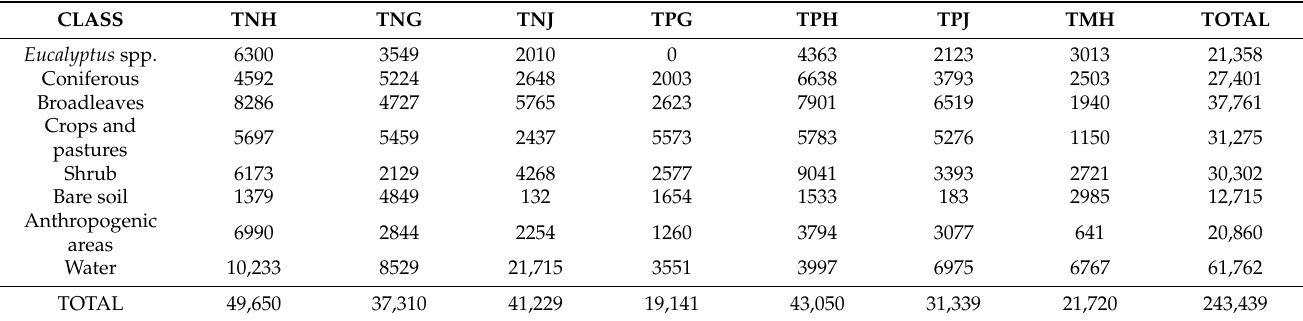
Table 4. Number of 20 × 20 m 2 training pixels by tile and class used to perform all of the supervised classifications presented in the